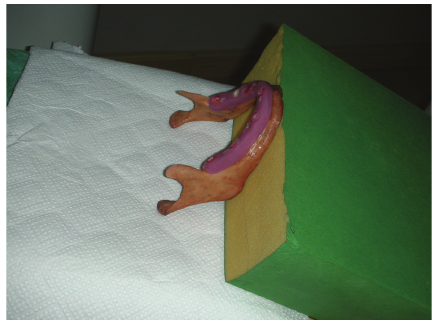
Figure 2: The surgical guide which was fabricated on the cast obtained from an impression of the alveolar process of the man- dible.